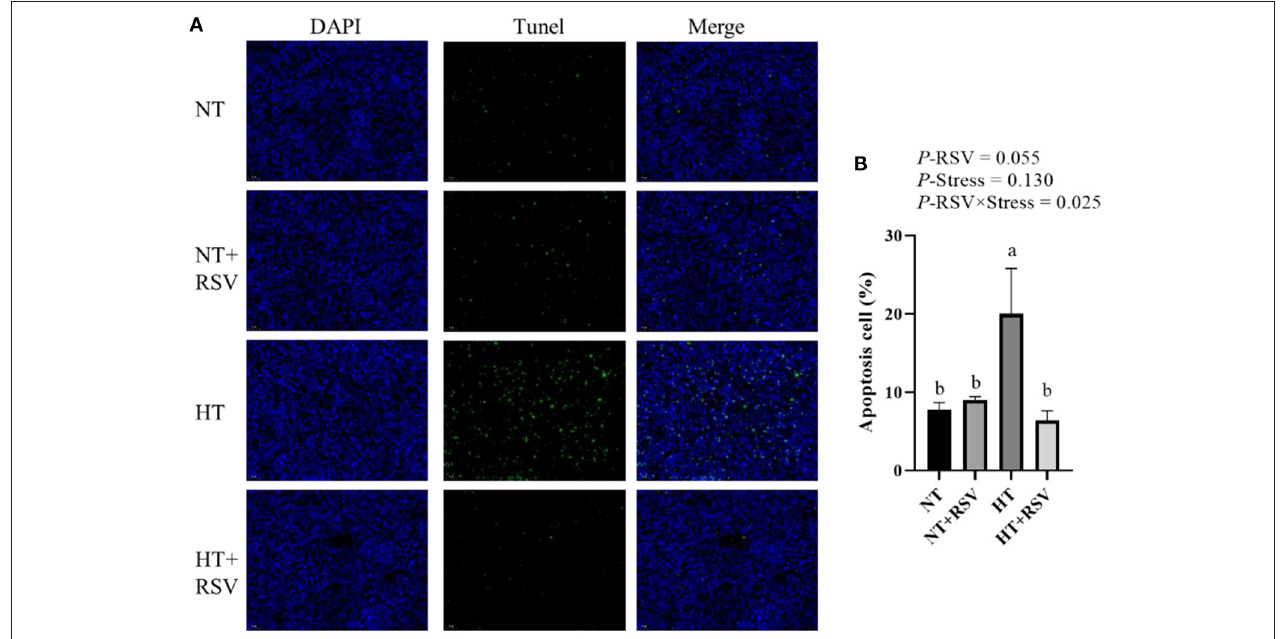
FIGURE 2 | The frequency of apoptosis in spleens of 42-day-old broilers (d 14 of heat treatment) detected by TUNEL assay. (A) TUNEL staining. The blue fluorescence represents the nucleus, whereas the green fluorescence represents apoptotic cells. The magnification is × 400. (B) The percentage of the apoptotic cells. Symbols and error bars represent means standard error. Bars represent the means ± SEM ( n = 6), bars with different letters are statistically significant in different treatments. P -values ( P -RSV, P -Stress, or P -RSV × Stress) ≤ 0.05 indicates RSV, heat stress, or the interaction between heat stress and RSV. RSV, resveratrol; NT, normal temperature; HT, heat